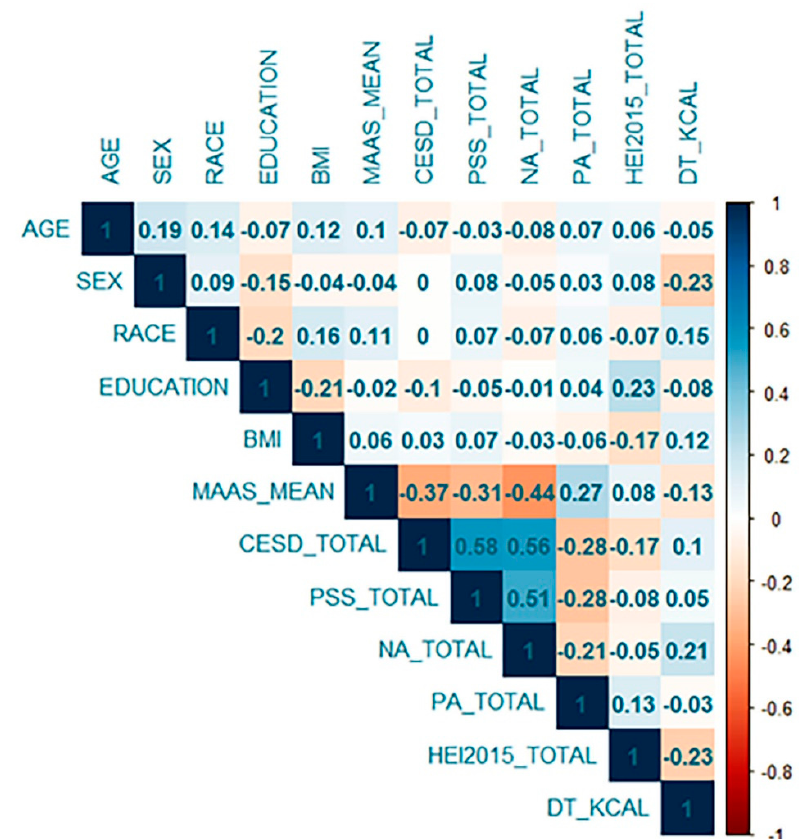
Figure 1. Correlation matrix among all demographic and clinical characteristics. Note: BMI = body mass index; MAAS = Mindful Awareness and Attention Scale; PSS = Perceived Stress Scale; CES-D = Center for Epidemiologic Studies Depression Scale; PANAS = Positive Affect Negative Affect Schedule; NA = negative affect; PA = positive affect; HEI = Healthy Eating Index; DT_KCAL = Daily total intake in kilocalories. Matrix created in R using the ‘corrplot’ package.